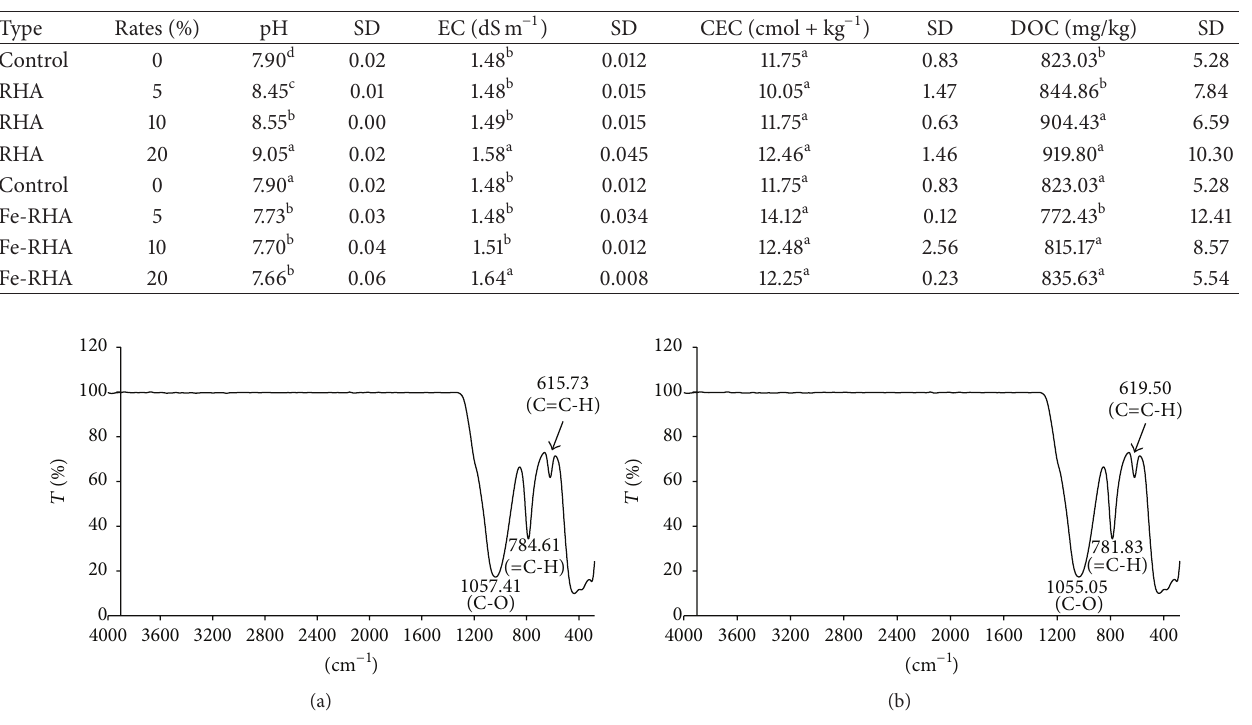
Table 4: The pH (1:2.5 w soil /v water ), EC ( 𝜇 Scm −1 ), and CEC (cmol (+) kg −1 ) of the mine tailings amended with the ashes (mean 𝑛 = 3 , ± SD). Different letters correspond to significant differences between rates of the same ash ( 𝑃 < 0.05) in the same column.